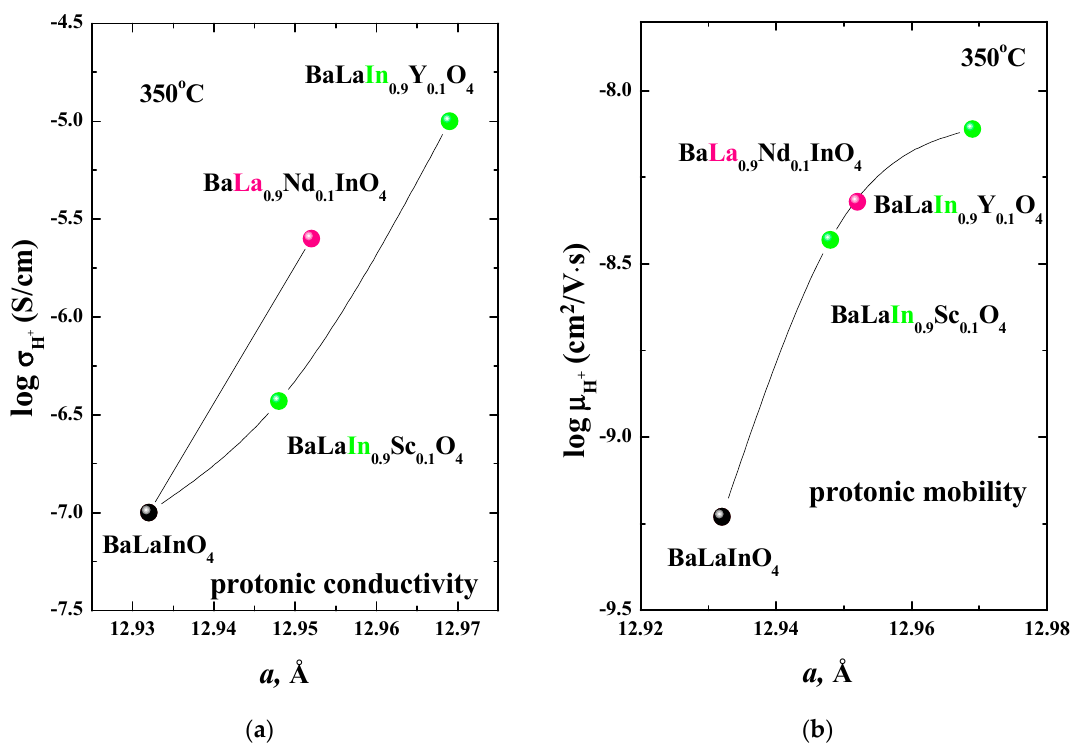
Figure 9. Dependencies of protonic conductivity ( a ) and mobility ( b ) from a lattice parameter for the compositions BaLa 0.9 Nd 0.1 InO 4 , BaLaIn 0.9 Sc 0.1 O 4 [54], BaLaIn 0.9 Y 0.1 O 4 [55], BaLaInO 4 [49] at 350 °C.